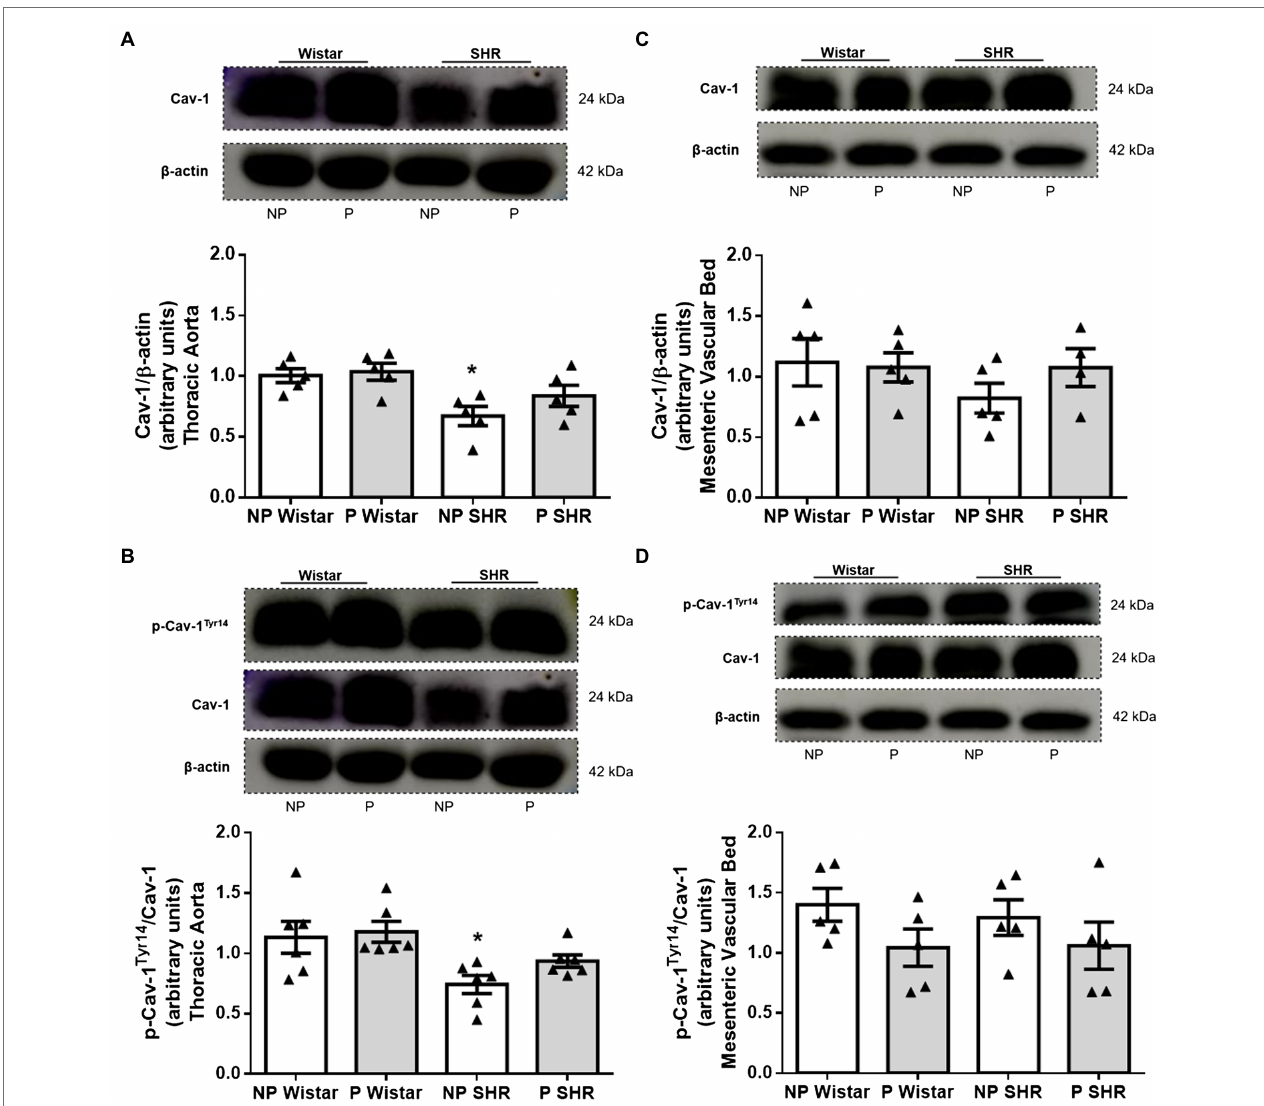
FIGURE 5 | Representative images and quantification of the caveolin-1 (Cav-1)/ β -actin (A,C) and p-Cav-1 Tyr14 /Cav-1 (B,D) expression in the aorta and resistance mesenteric artery homogenates of non-pregnant (NP) and pregnant (P) Wistar and spontaneously hypertensive (SHR) rats. The bars represent the mean ± SEM of the results obtained in the aorta ( n = 5) from the different groups. * p < 0.05 NP SHR versus NP Wistar rats and P Wistar